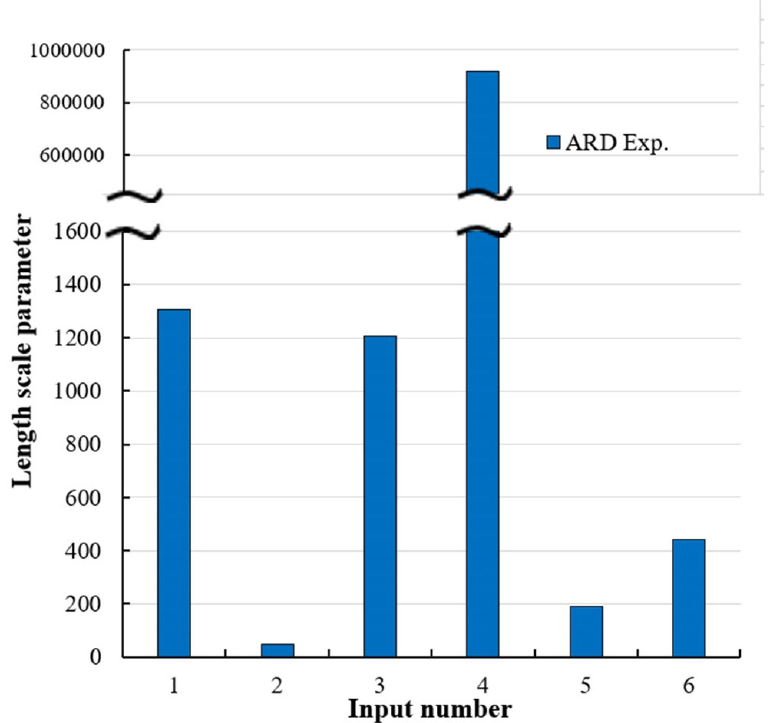
Figure 12. Values of the distance scale parameters in the model with the ARD exponential covariance function.